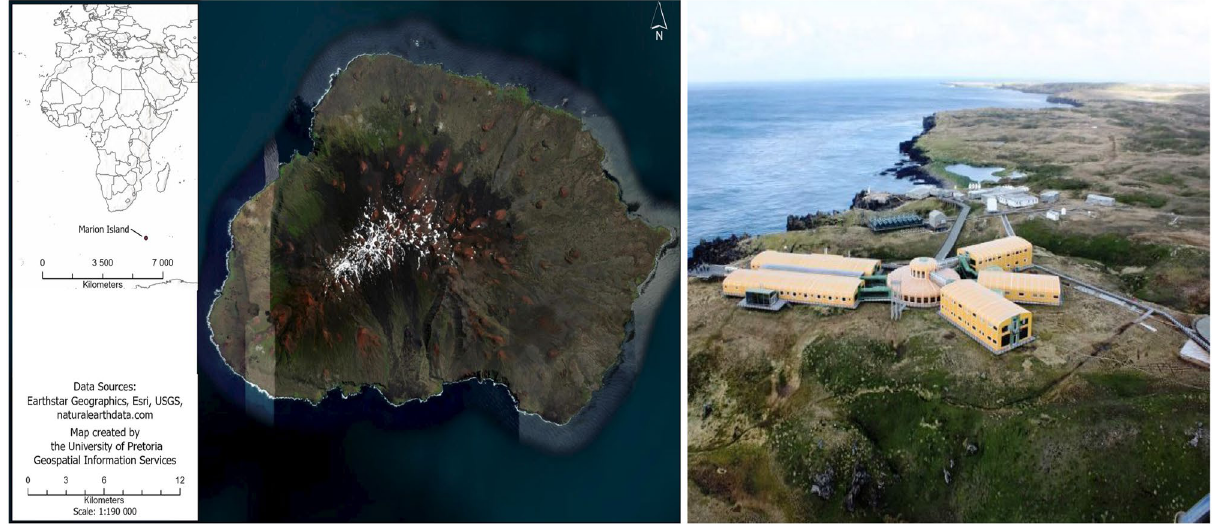
Figure 1. Marion island (created by the University of Pretoria) and meteorological research station on the island (provided by Antarctic Legacy of South Africa http:// www. antar cticl egacy. org and https:// blogs. sun. ac.